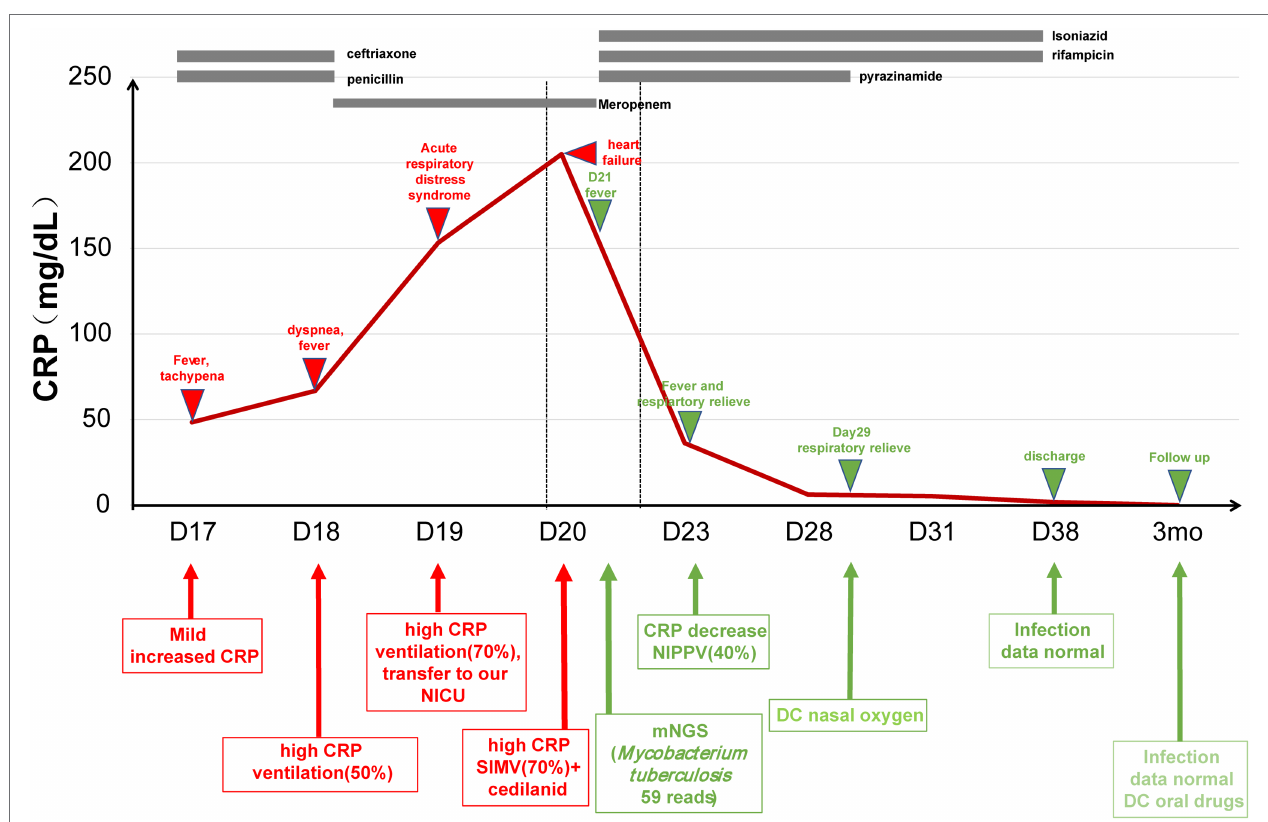
FIGURE 2 | The treatment course in Mycobacterium tuberculosis case. CRP, C-reactive protein; NICU, neonatal intensive care unit; and NIPPV, non-invasive positive pressure